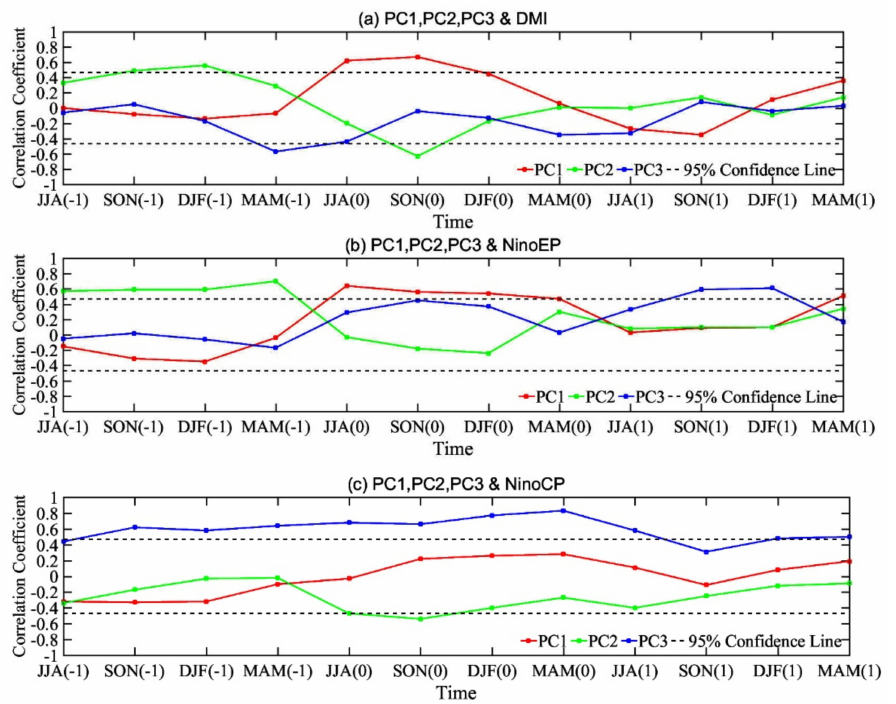
Figure 6. Lead–lag correlations between principal components (PC1, PC2, and PC3) and climate indices of ( a ) DMI, ( b ) NinoEP, and ( c ) NinoCP. The dashed line indicates a 95% confidence